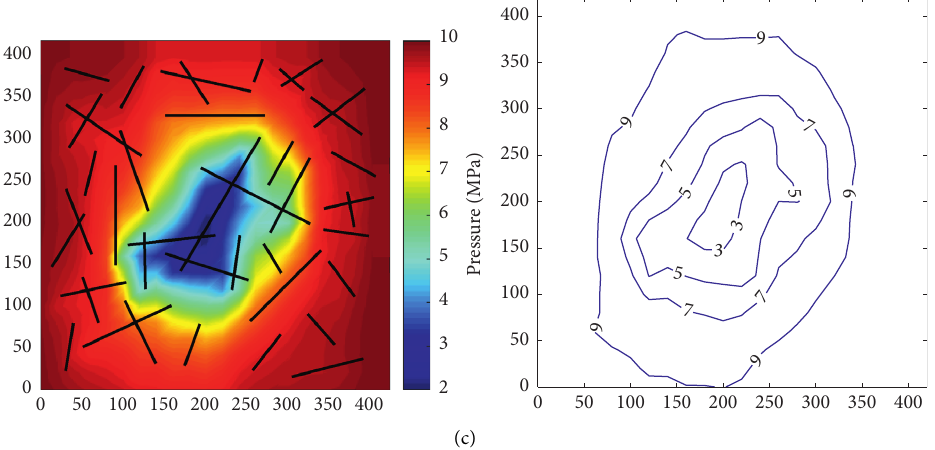
Figure 21: Oil pressure profiles when (a) k